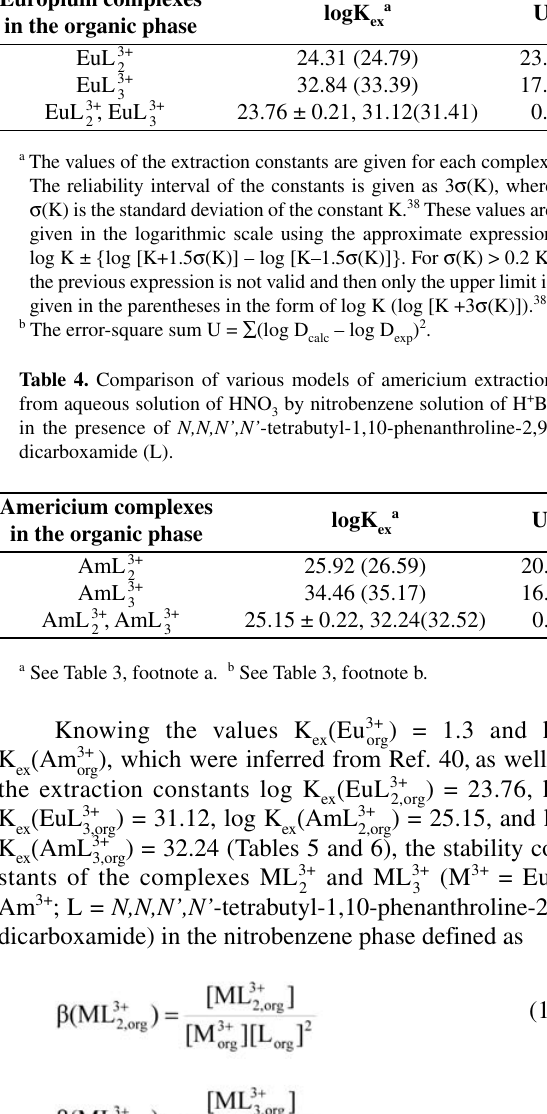
Table 3. Comparison of various models of europium extraction from aqueous solution of HNO by nitrobenzene solution of H + B – 3 in the presence of N,N,N’,N’ -tetrabutyl-1,10-phenanthroline-2,9- dicarboxamide (L). Europium complexes